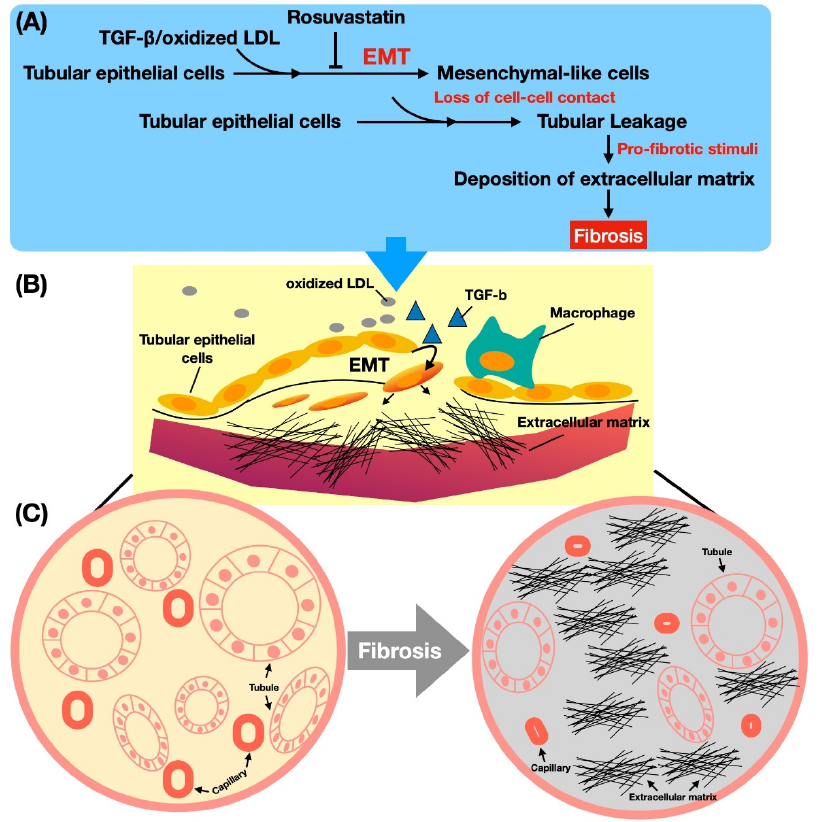
Figure 4. The mechanism of oxidized LDL boosting TGF- β on the EMT process in renal tubular cells. Based on the results of the in vitro studies, we schematically illustrate the underling mechanism of oxidized LDL boosting TGF- β on the EMT process in renal tubular cells, i.e., NRK-52E cells. Note that the upper panel ( A ) used the textual description to fully explain the pathological process of the renal tubular epithelial cells in the middle panel ( B ) after the oxidized LDL or TGF- β treatment. On the other hand, the lower panel ( C ) fundamentally concluded the final pathological outcomes of renal tubular epithelial cells after the oxidized LDL or TGF- β treatment. To illustrate this underlying mechanism of oxidized LDL or TGF- β induced renal tubular epithelial cells into EMT would lead to the reader easily understanding the impact of oxidized LD/TGF- β on the pathogenesis of EMT in the setting of CKD. A = upper panel; B = middle panel; C = lower panel. 3.8. The Time Courses of Circulating Levels of BUN and Creatinine and the Ratio of Urine Protein to Urine Creatinine (Figure 5) At baseline prior to CKD induction, the circulatory levels of BUN and creatinine, and the ratio of urine protein to urine creatinine, did not differ among groups 1 (sham-oper- ated control), 2 (CKD + 0.5cc normal saline), 3 (CKD + oxidized LDL), and 4 (CKD + oxi- dized LDL + rosuvastatin). Rosuvastatin acted as a lipid-lowering agent for the treatment of LDL elevation. By day 14 after CKD induction, these parameters were significantly lower in group 1 than in groups 2 to 4, but they showed no difference among groups 2 to 4. However, by days 28 and 42 after CKD induction, these parameters were significantly higher in group 3 than in other groups, significantly higher in groups 2 and 4 than in group 1, but these parameters did not differ between groups 2 and 4. These findings